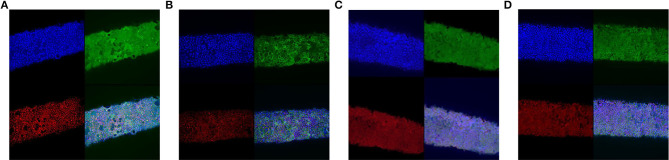
Confocal microscope images of Caco-2 cells in PDFS after 10 days under 30 (A), 60 (B), 90 (C), and 125 (D) μL/min. Images show staining for tight-junctions (ZO-1, red), villi (villin, green), and nuclei (DAPI, blue).